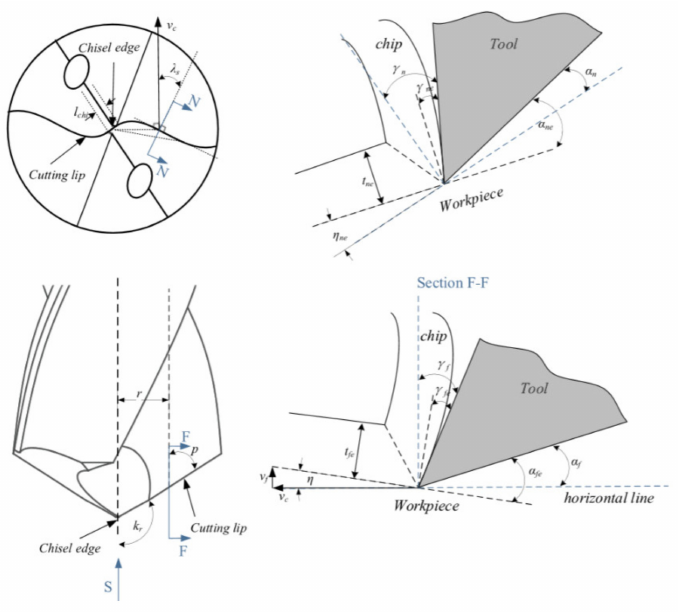
Figure 1. Schematic view of cutting geometry with cross sectional view at di ff erent selected elements (with kind permission from Elsevier